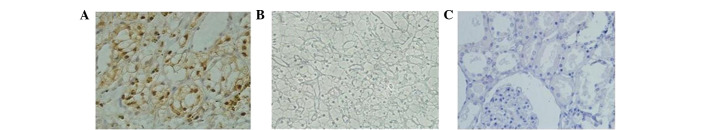
B7-H4 expression in normal kidney and RCC tissues. (A) Representative RCC tumor specimen with marked membranous tumor cell B7-H4 immunohistochemical staining. (B) RCC tumor specimen with negative tumor cell B7-H4 endothelial staining. (C) Normal tumor-adjacent kidney specimen without B7-H4 staining (magnification, ×200). RCC, renal cell carcinoma.